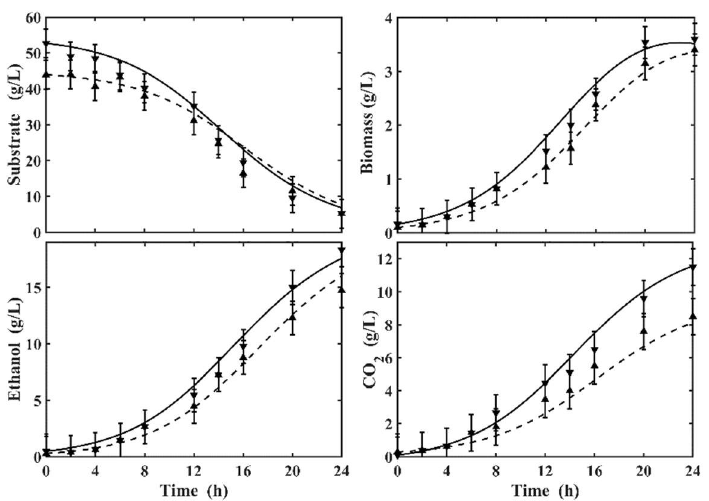
Figure 6. Dynamic behavior of the proposed model, experimentally validated for the different initial concentrations of glucose, 54 g/L (solid line) and 44 g/L (dashed line).